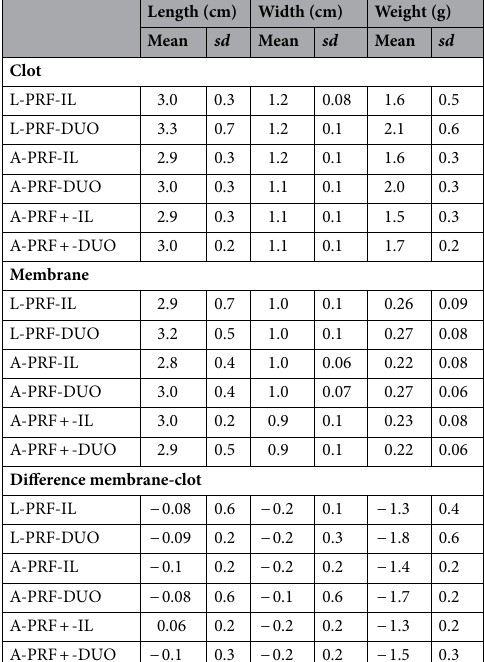
Table 1. Clots and membrane dimensions (mean and standard deviation) in all protocols (n = 8). Difference (Δ) between clots and membranes in terms of length, width, and weight. sd: standard